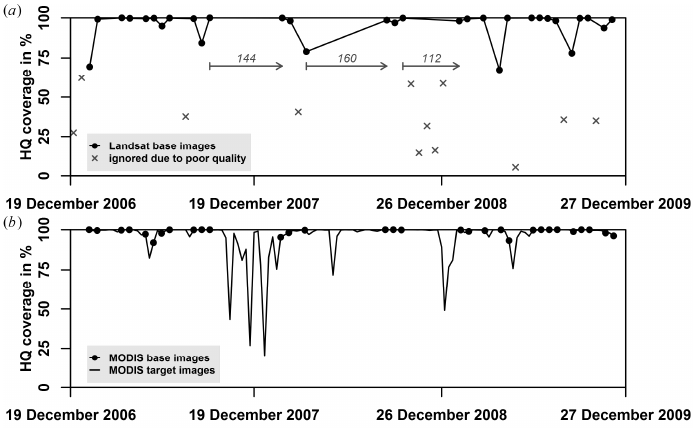
Figure 4. Landsat ( a ) and MODIS ( b ) input images for generating the dense synthetic Landsat-like time series. A high quality (HQ) observation is an observation, which passed the quality tests. Landsat images with more than two-third HQ pixels observations were used for the prediction. The three largest data gaps are indicated by arrows.